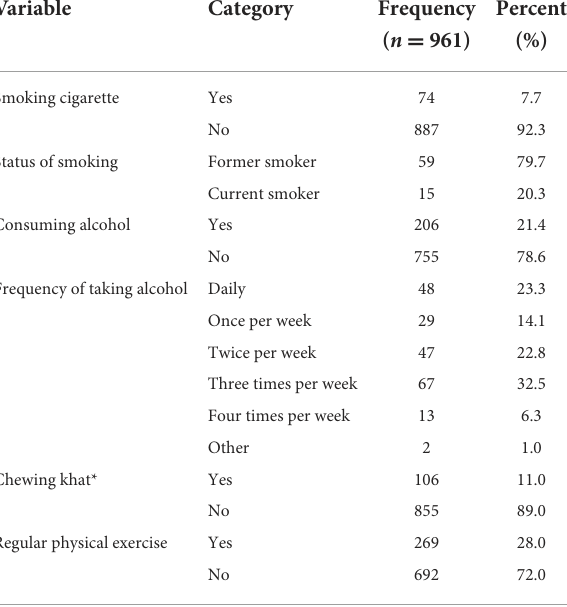
TABLE 2 Variables related to the lifestyle of the study participants at Bench Maji Zone, Ethiopia, 2018.